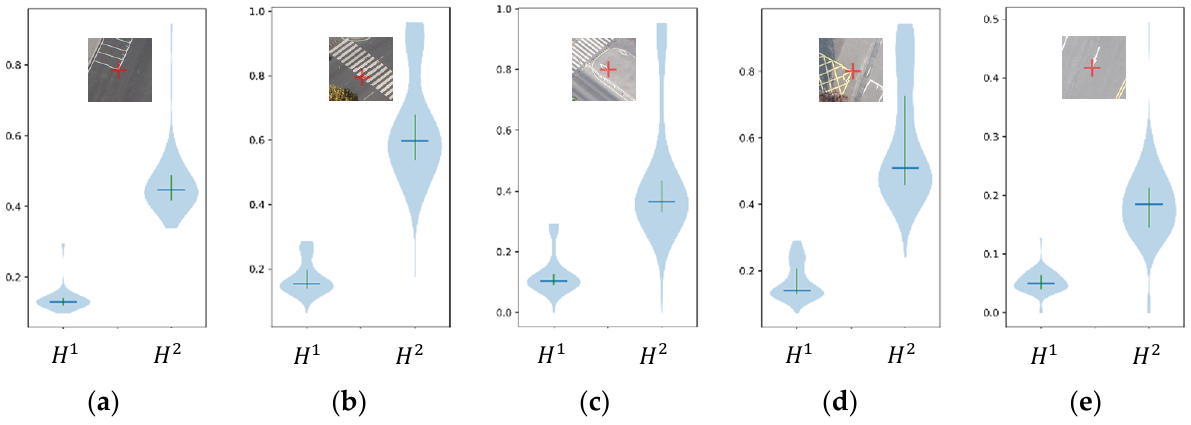
Figure 8. The 1-d and 2-d entropy value distribution for the five GCPs: ( a ) GCP1; ( b ) GCP2; ( c ) GCP3; ( d ) GCP4; ( e ) GCP5. The left column in each subfigure represents 1-d entropy, and the right column represents 2-d entropy; the surroundings of the five GCPs are shown at the mid-upper side in each subfigure, respectively. After obtaining the entropy quantiles of ROIs, the entropy anomaly recognition fences are computed for GCP1~GCP5, respectively. The ROIs whose entropy values fall within the fences are judged as normal, and the others are considered as outliers. The results are listed in Table 3. For example, 3, 25, 15, 15, and 3 were judged to be abnormal among 93,